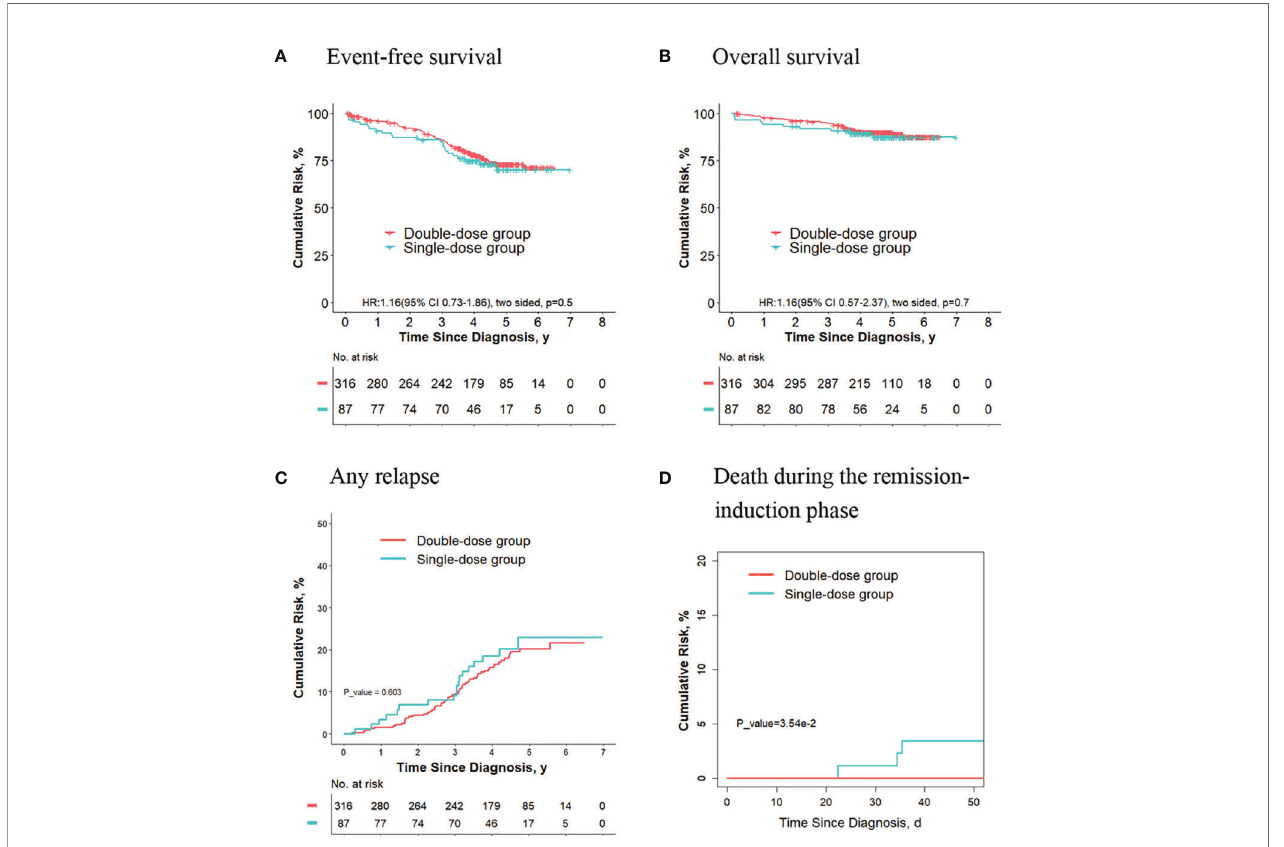
FIGURE 1 | Analysis of survival and cumulative risk of relapse and early death for patients with ALL in fi nal intermediate/high-risk